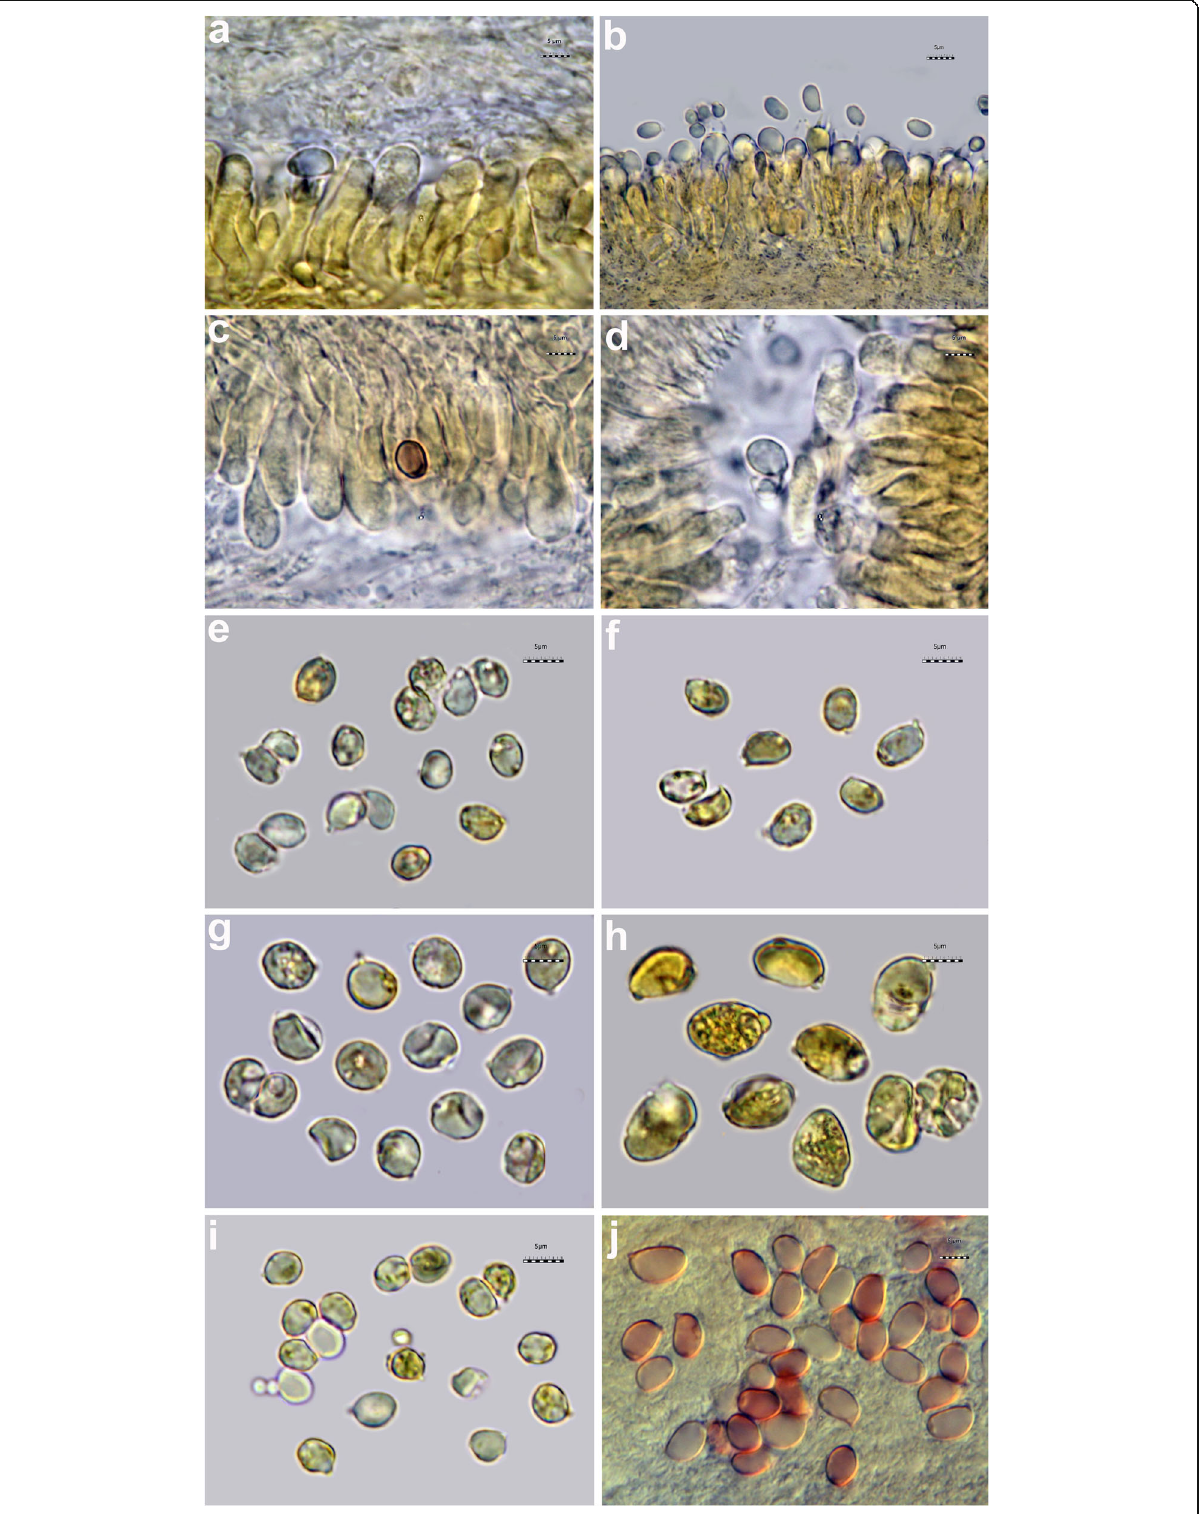
Fig. 3 Spores and basidia of Tricholoma species observed in Melzer ’ s after heating. a – b T . argyraceum (AMB 17211) c – d T. josserandii (AMB 17407) e T . caligatum (AMB 17231) f T . frondosae (AMB 17243) g T. fucatum (AMB 17300) h T . inamoenum (AMB 17367) i T . orirubens (AMB 17410) j T . terreum (AMB 17444). Photos by L.